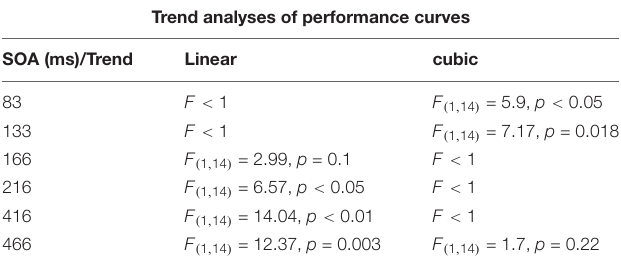
distance ( F ( 12 , 168 ) = 4.54, p < 0.001). There was also a